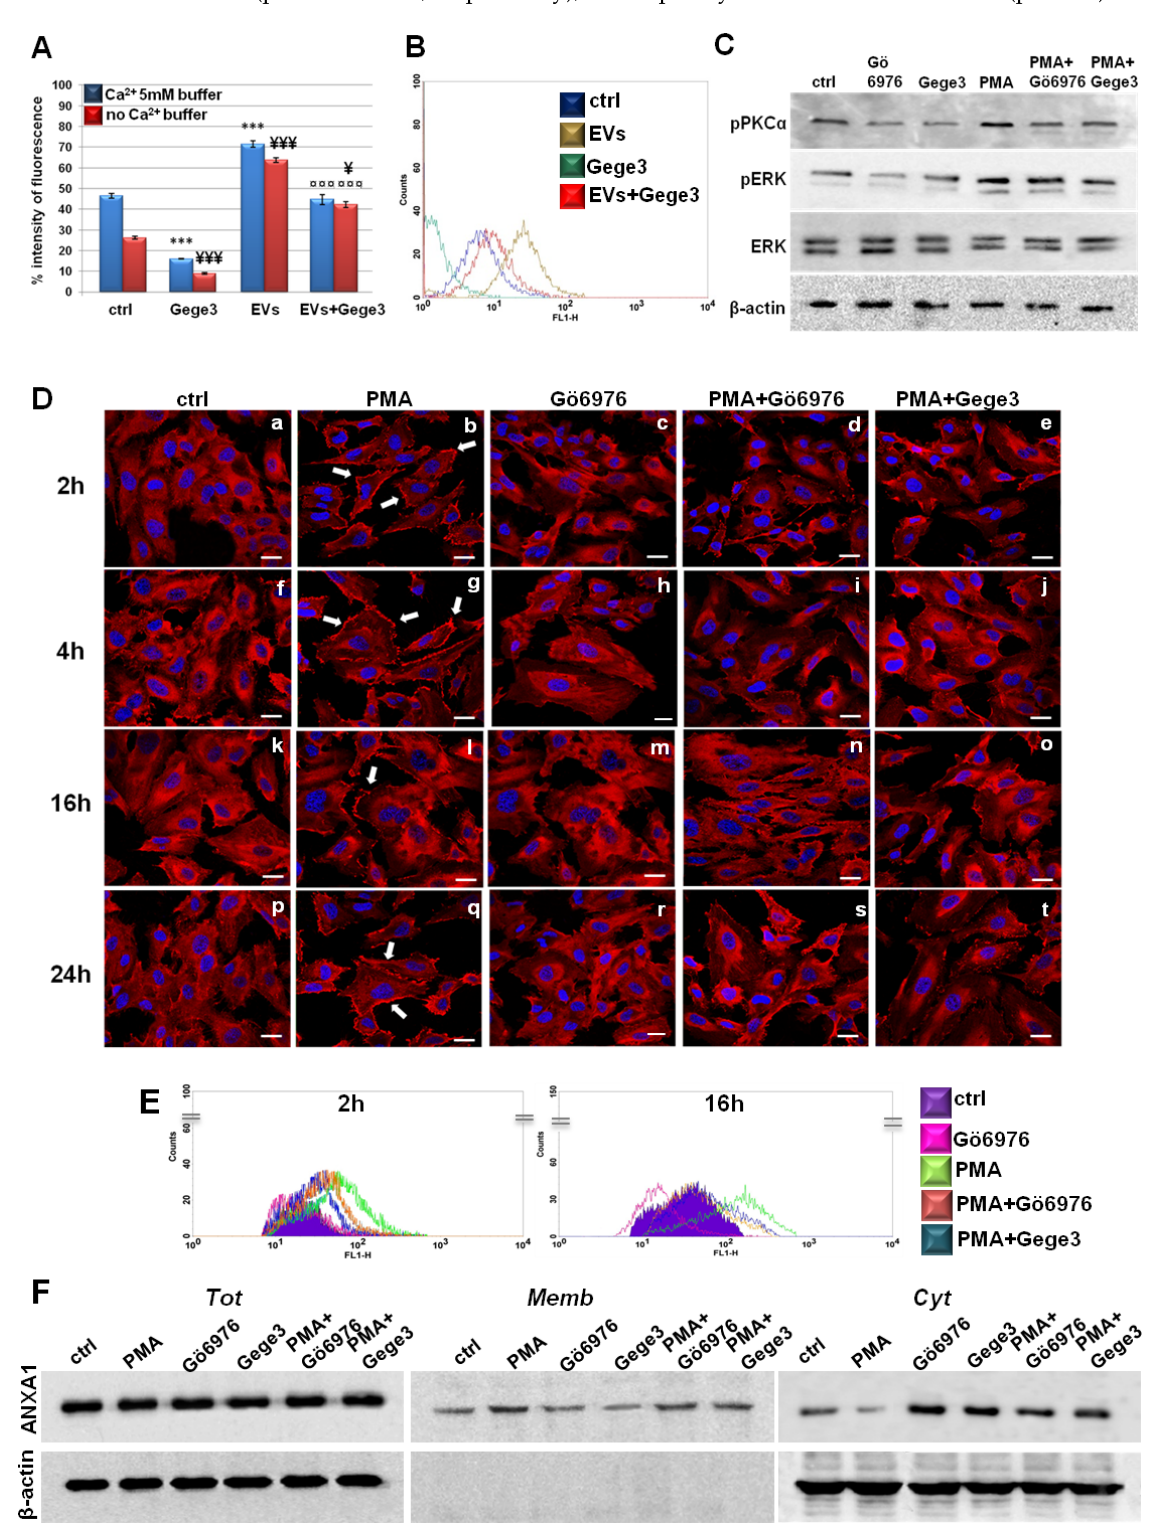
Figure 5. Endothelial cells answers to EVs in presence of Gege3 ( A ) Effects of Gege3 (10 µ M), PC-derived EVs with and without Gege3, monitored using the probe Fluo-4 a.m. In the histogram blue bars refer to the cytometry analysis of cells